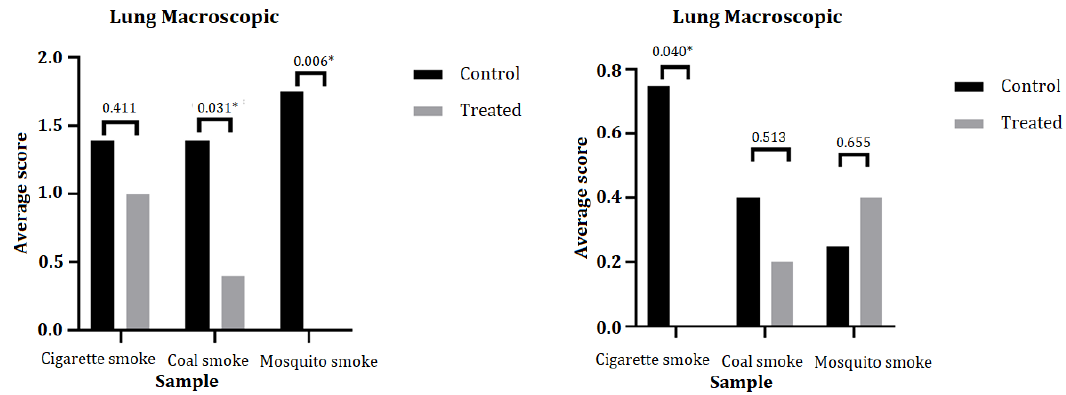
Figure 2. Gross examination scoring and statistical analysis of lung (A) and liver